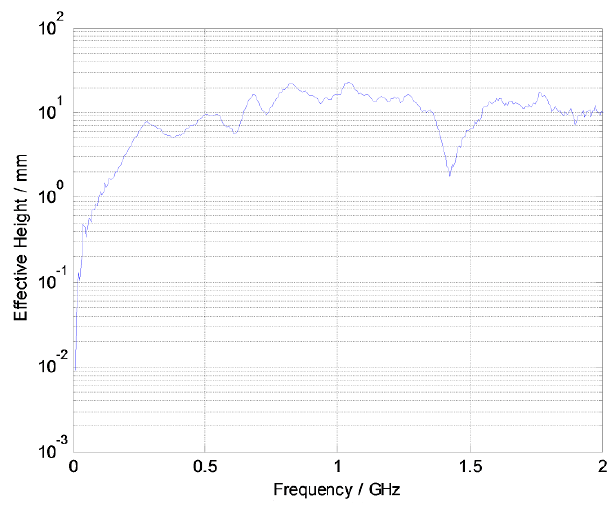
Figure 8. Sensitivity curve of the elliptical dipole printed antenna.